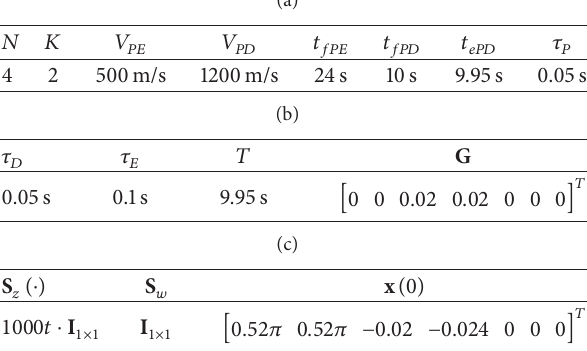
Table 1: Simulation parameters of noncooperative case.